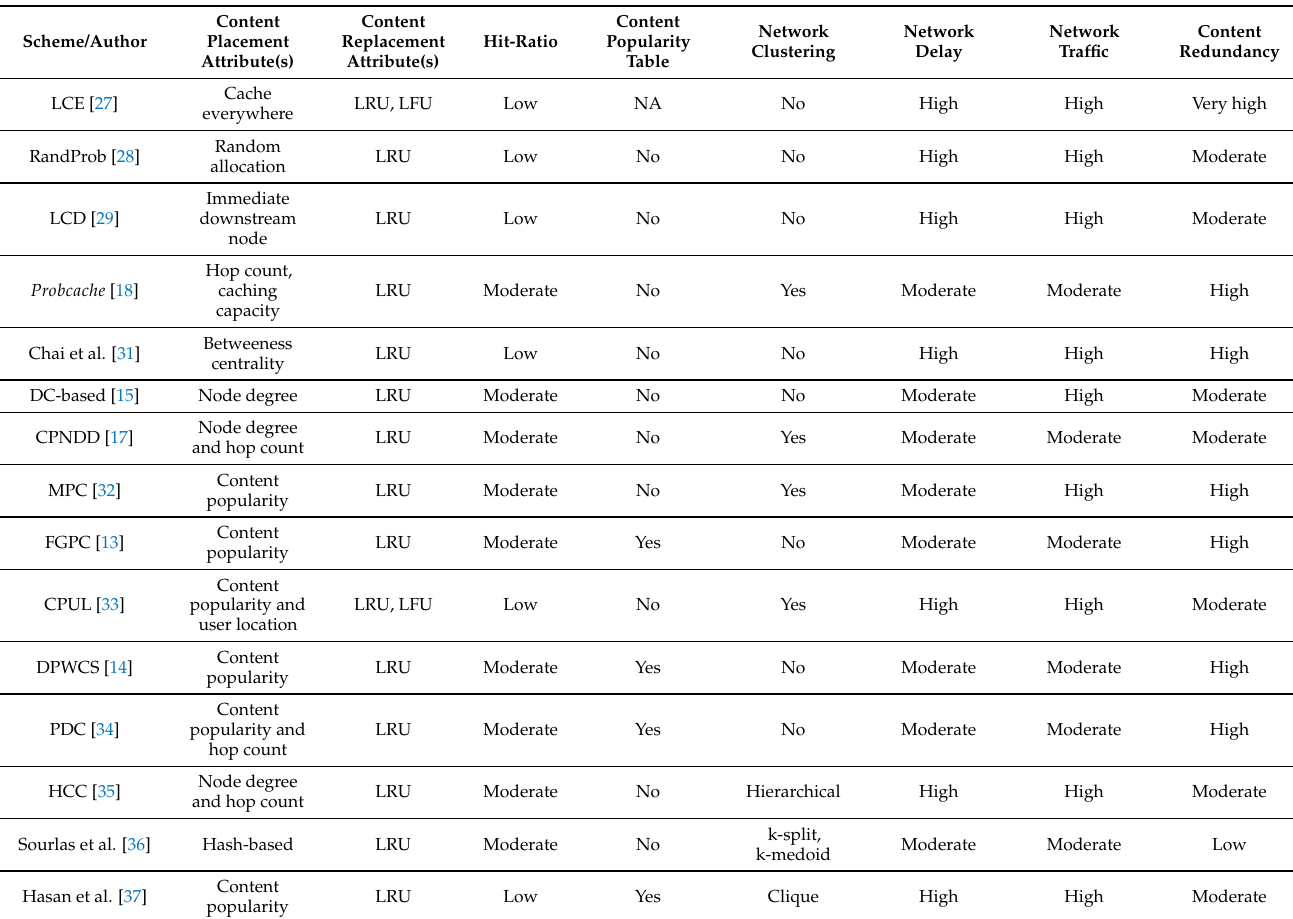
Table 1. Features of the existing caching